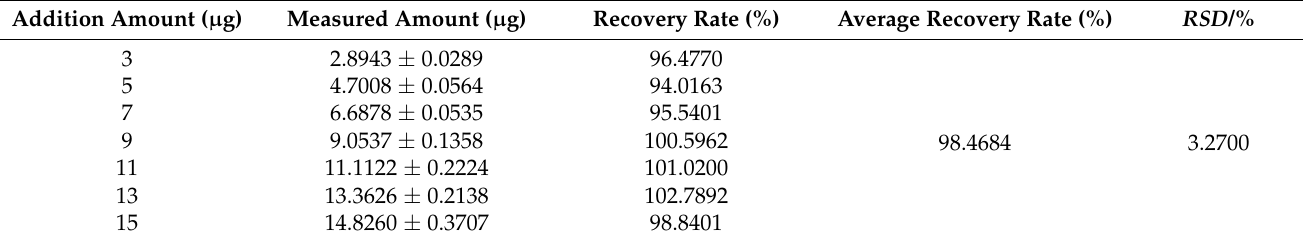
Table 2. Spike and recovery